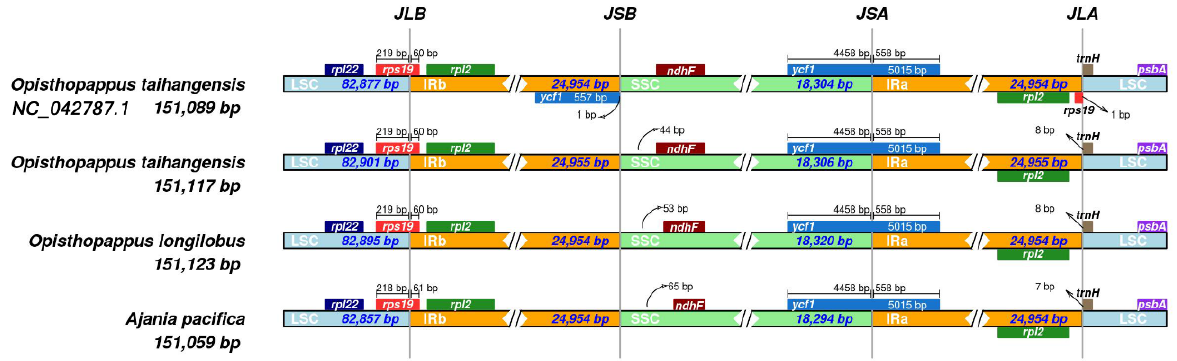
Figure 8. Comparative analysis of chloroplast genomic boundaries of four species cp genome.